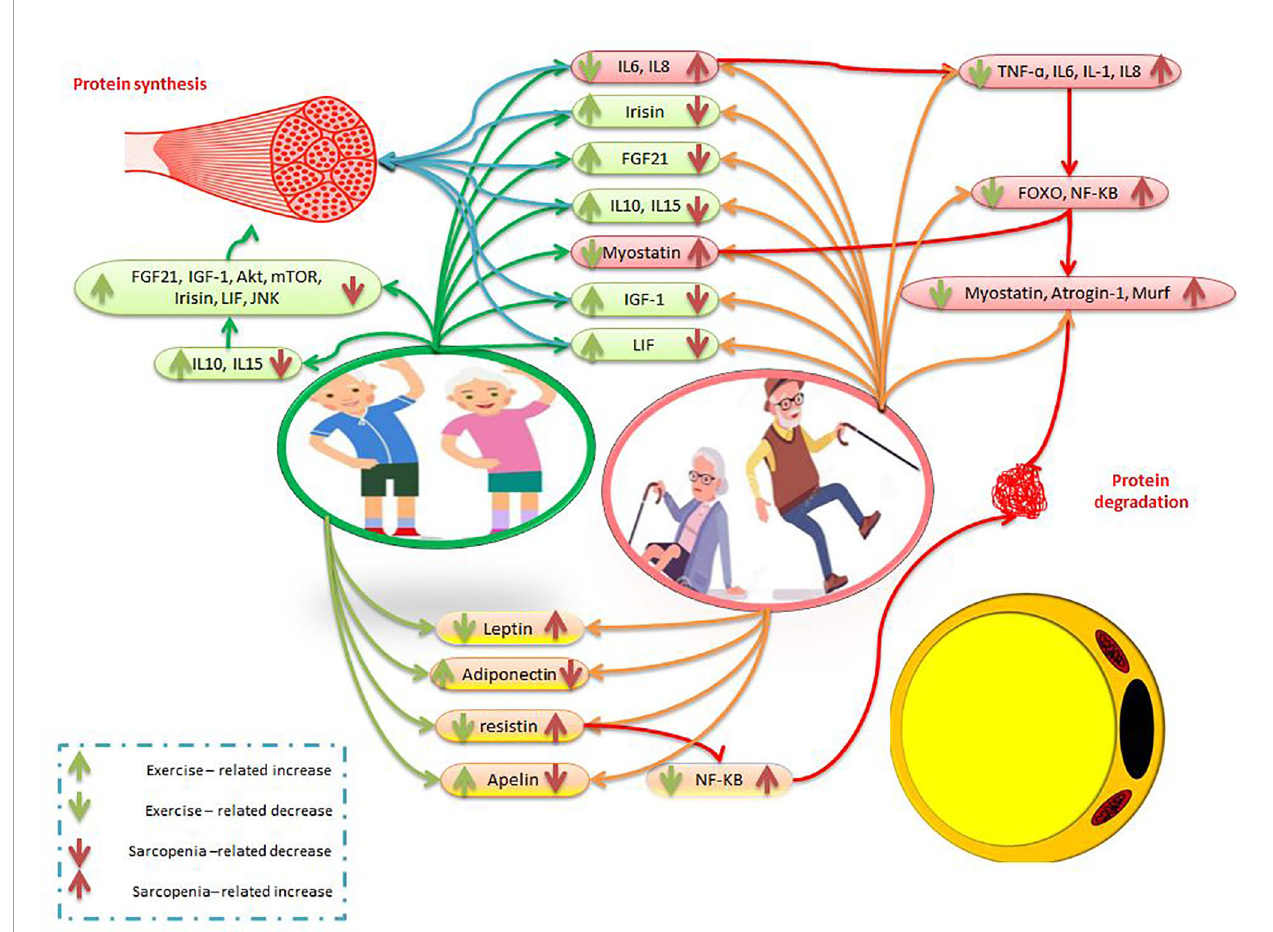
FIGURE 2 | The effects of exercise and sarcopenia obesity on myokines and adipokines. The description is available in the